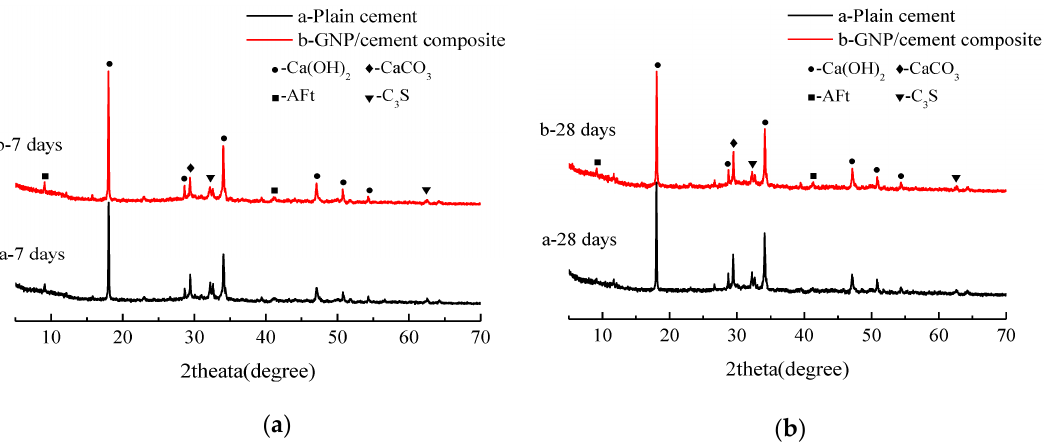
Figure 15. XRD patterns of GNP cement composite and plain cement at ( a ) 7-day and ( b ) 28 days. Reproduced with permission from [33], MDPI, 2016.